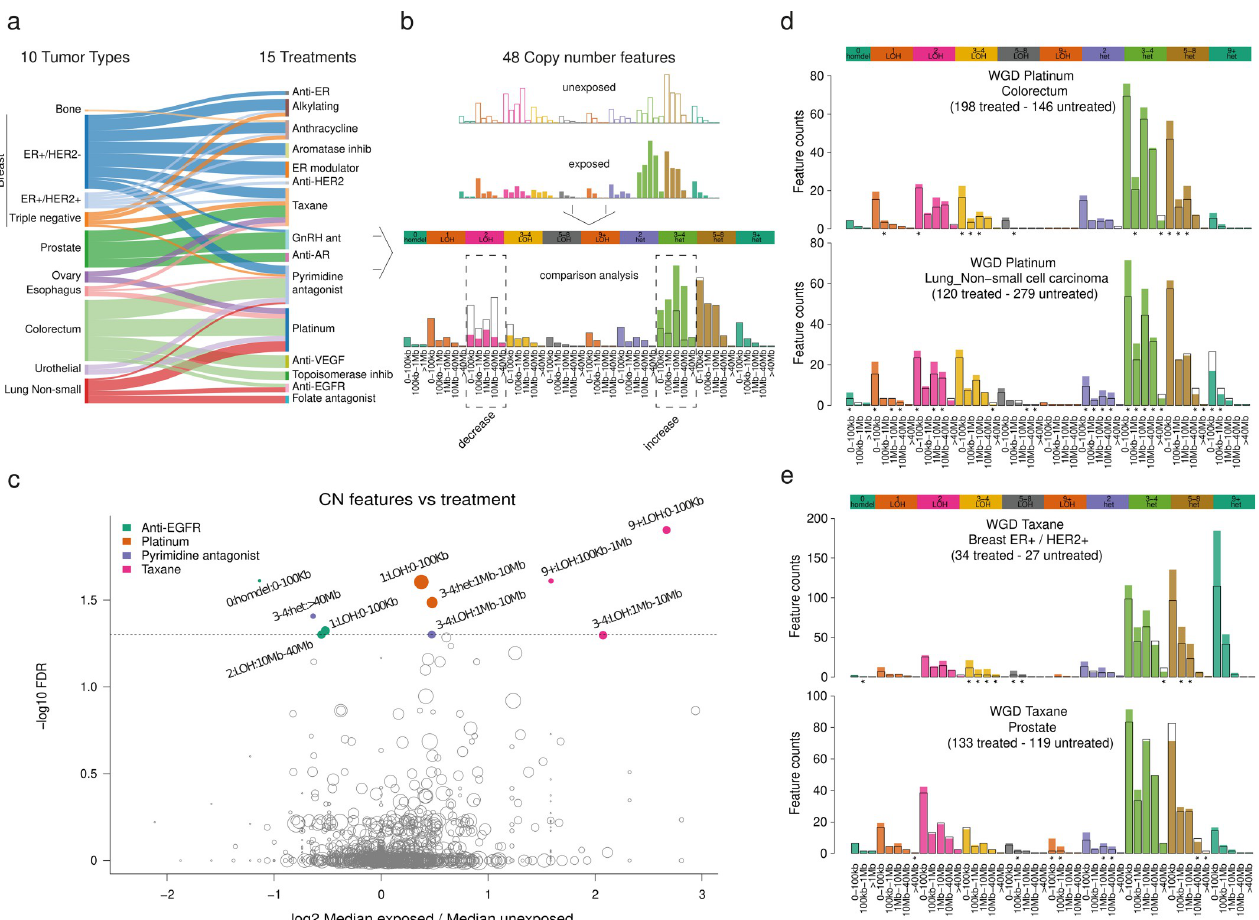
Fig 2. The profile of chromosomal fragments associated with anticancer therapies. a) Cancer types (sites of origin) represented in the HMF metastatic cohort and anticancer treatments to which they were exposed. Numbers of tumors of different cancer types in the HMF cohort exposed to anticancer therapies appear also in S2 Table. b) Toy representation of CN categories computed for every tumor and their values for exposed and unexposed tumors (top). Bars represent the count of chromosomal fragments in each CN category. Comparison across CN categories reveals several that appear significantly increased or decreased across exposed tumors with respect to their unexposed counterparts. The CN and ploidy of each category are always shown above the graph, while the range of sizes of chromosomal fragments represented by each bar appear below. For each comparison (one per CN category), a p-value and fold-change can be computed. c) Results (minus logarithm corrected p-value of the Wilcoxon signed-rank test vs fold-change) of 1782 comparisons carried out between CN categories of tumors within a cancer type that were exposed or unexposed to a given anticancer therapy. Significant comparisons (False Discovery Rate corrected p-value below 0.05) d) Results of the comparison of CN categories across WGD colorectal (top) and lung (bottom) tumors exposed or unexposed to platinum-based drugs in the HMF cohort. Significant comparisons (uncorrected p-value below 0.05) are highlighted with asterisks below each graph. e) Results of the comparison of CN categories across WGD breast ER+/HER2+ (top) and prostate (bottom) tumors exposed or unexposed to taxanes in the HMF cohort. Significant comparisons (uncorrected p-value below 0.05) are highlighted with asterisks below each graph.